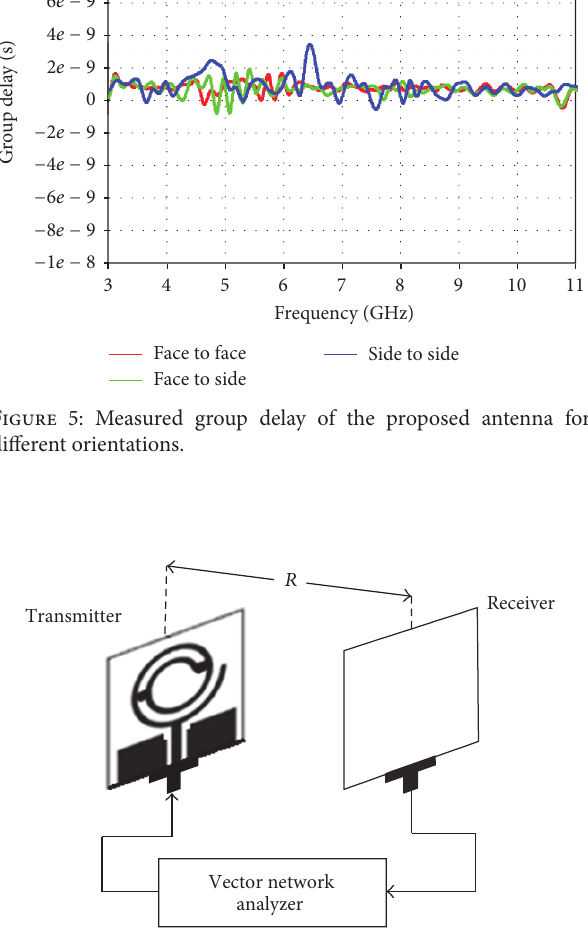
Figure 4: Measured peak gain of the proposed antenna.